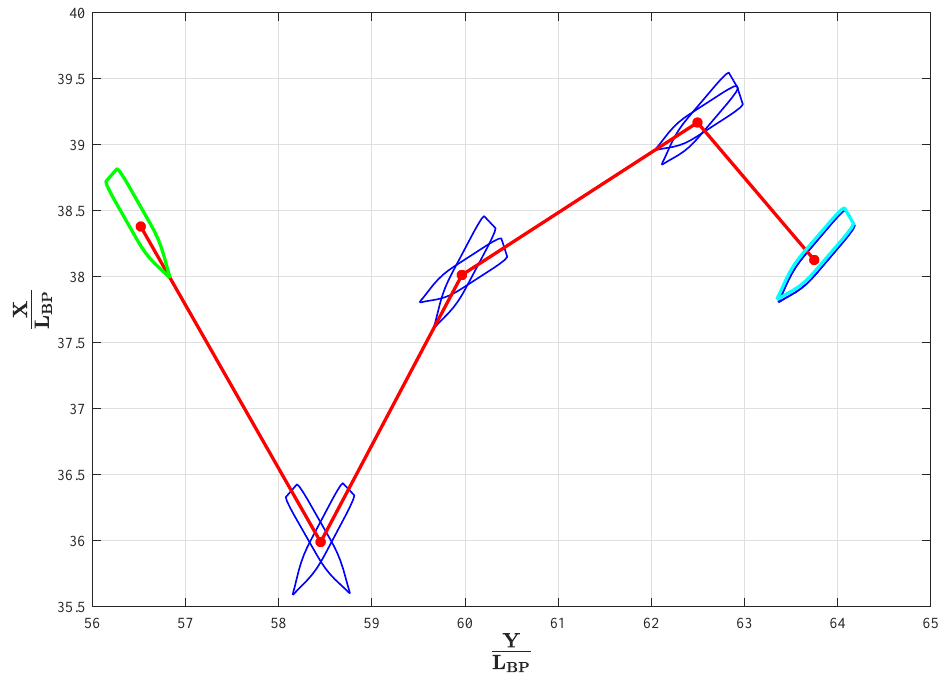
Figure 7. Low-speed desired path. The green waterline represents the starting point while the light blue represents the end of the manoeuvre.